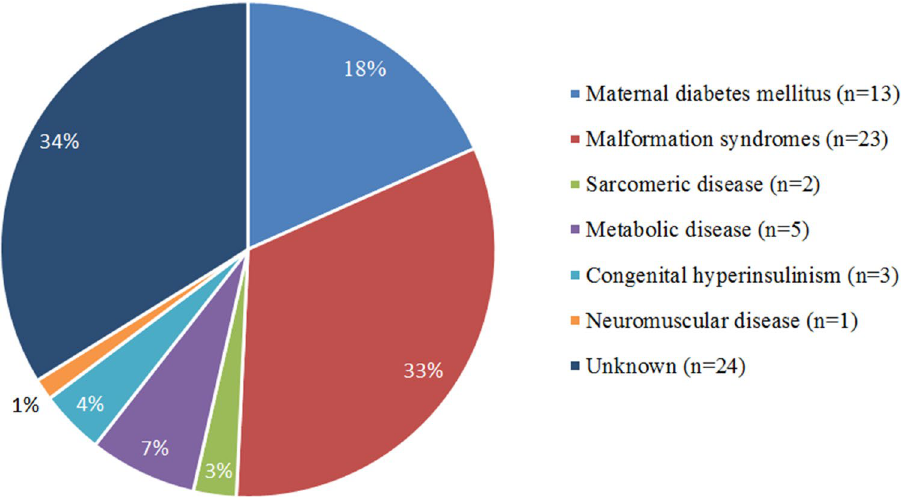
Figure 1. Underlying etiologies of cardiac hypertrophy in infants and their distribution. Malformation syndromes: Noonan (n = 12), Cantu (n = 3), Costello (n = 2), Berardinelli-Seip Congenital Lipodystrophy (n = 2), 1P36 chromosomal deletion (n = 1), Trisomie 18 (n = 1), Leprechaunism (n = 1), Beckwith-Wiedemann (n = 1); Sarcomeric disease: MYBPC3-gene mutations; Metabolic disease: Pompe (n = 3), GM1-gangliosidose (n = 1), VLCADD (n = 1); Congenital hyperinsulinism: Heterozygous mutation KCNJ11-gene (n = 1), hyperinsulinism (n = 1), after extreme dysmaturity (n = 1); Neuromuscular disease: Nemaline myopathy (mutation ACTA1-gene); Unknown: Variant of unknown significance (VUS) RYR2-gene, deletion RYR2-gene, paternal variant MYH7- gene (n = 2 siblings, 1 died), VUS MYH7-gene (n =